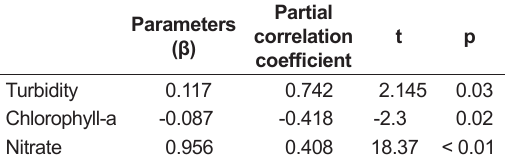
Figure 4. Copepod abundance in the different sampling periods (A) and points (B). Symbol = mean abundance values (ind.m -3 ); vertical bars = standard error. Table 5. Summary of the multiple regression model between copepod abundance (response variable) and values of turbidity, chlorophyll-a, and nitrate (explanatory variables); t corresponds to t test of parameters significance; p is the probability to find t higher than the